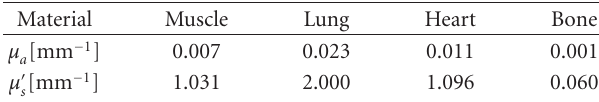
Table 1: Optical properties of the physical heterogeneous phantom. Material